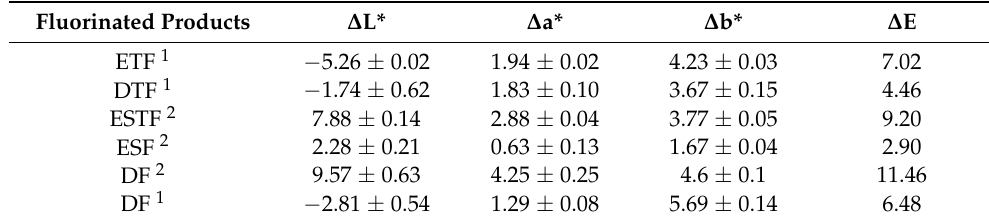
Table 5. Color variations of wood surfaces after coating.